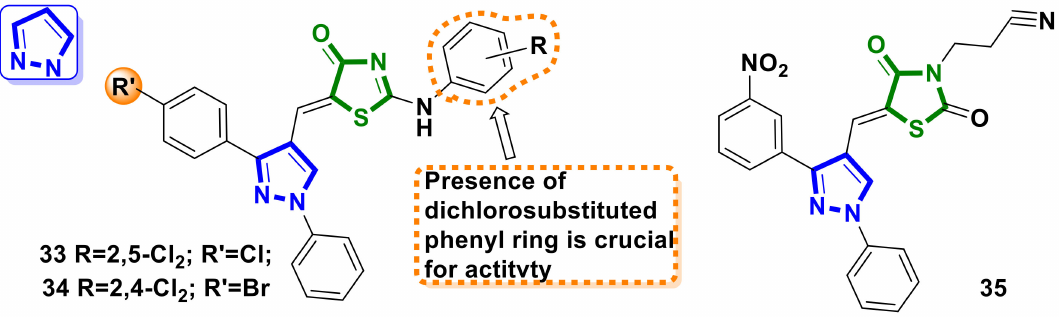
Figure 14. Structure of pyrazole–4-thiazolidinone hybrid molecules as potential anticancer agents.